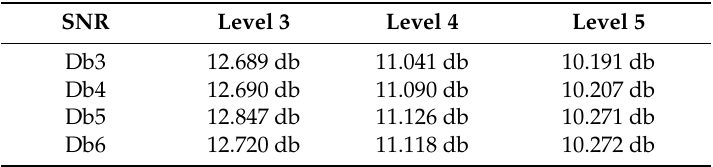
Table 7. Signal to noise ratio under different combinations of Db wavelets.